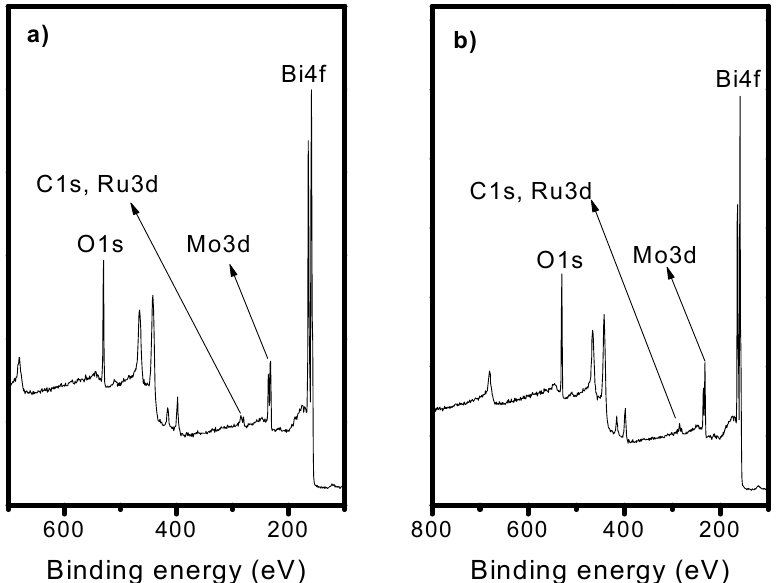
performed for this compound confirmed its presence (Figure 4). This BE signal matched Ru and was detected at 280.6 and 280.3 eV. These signals can be attributed to the presence of Ru–O bonds within the Bi 2 Mo 1 − x Ru x O 6 structure. This outcome agrees with the results discussed in the XRD section, where the ruthenium oxide phase was not found, similar to previous findings [35]. Figure 5 shows the XPS analysis for CeO 2 / Bi 2 Mo 0.95 Ru 0.05 O 6 (OCMBR1) and CeO 2 / Bi 2 Mo 0.97 Ru 0.03 O 6 (OCMBR2) supported catalysts. In addition to Bi, Ru, and O, the representative signal of cerium (Ce3d) with a BE of 886.08 eV, corresponding to the Ce–O interaction in CeO 2 , was established [36–38].